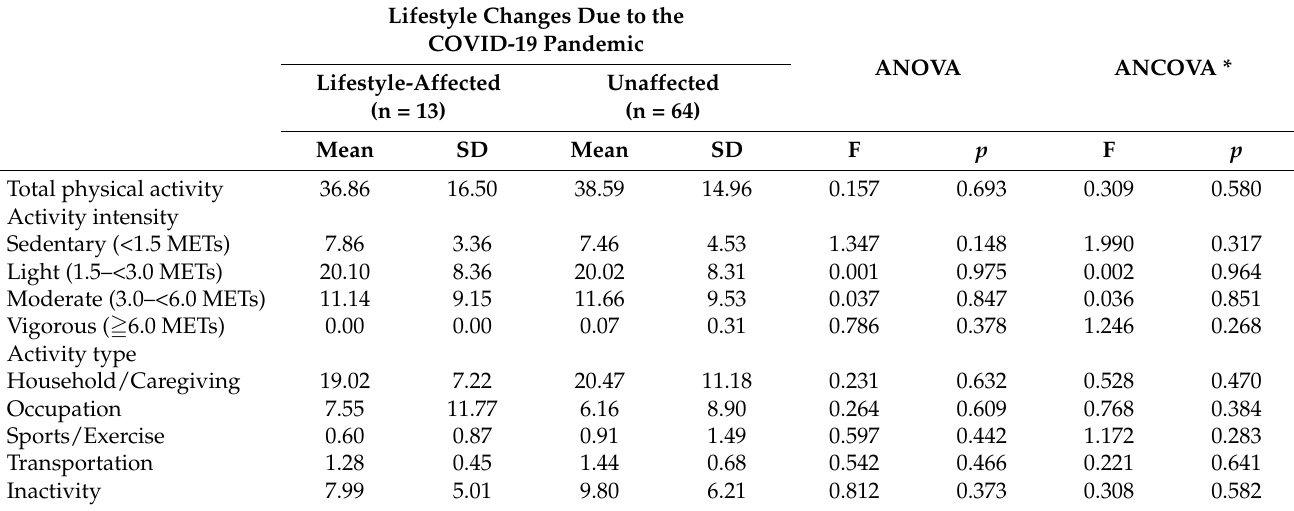
Table 6. Differences in physical activity levels between the lifestyle-affected group and unaffected group in multiparas (n =